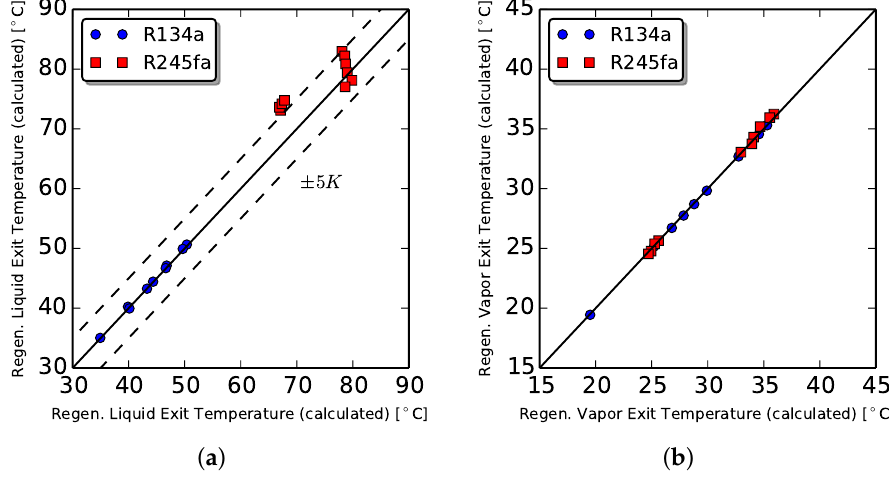
Figure 12. Validation of PHEX model working as a